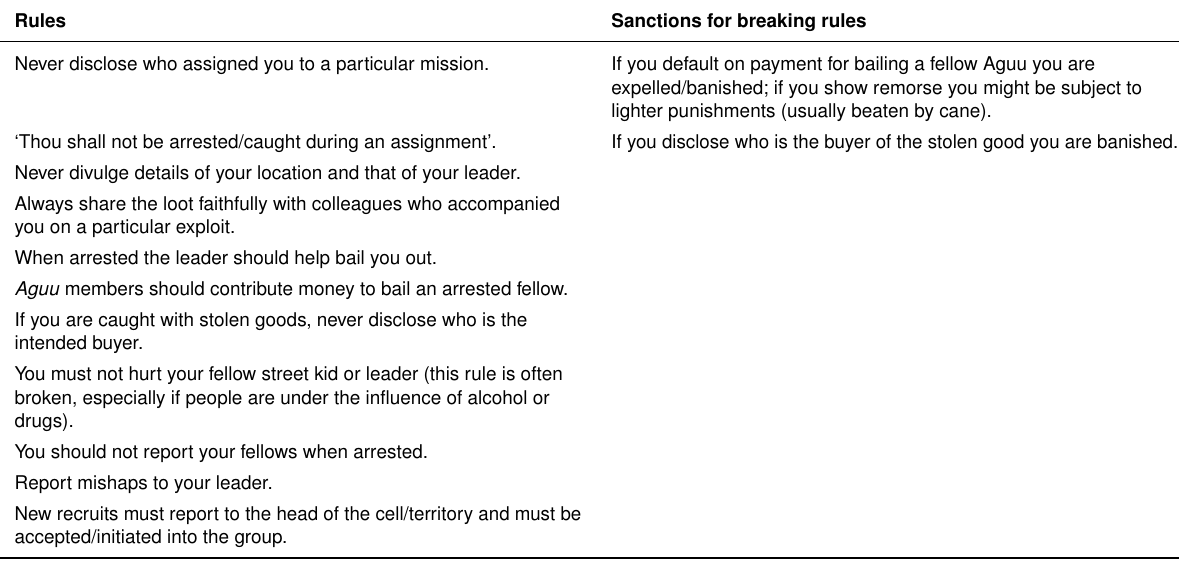
Table 3. Example of Rules and Sanctions for Aguu